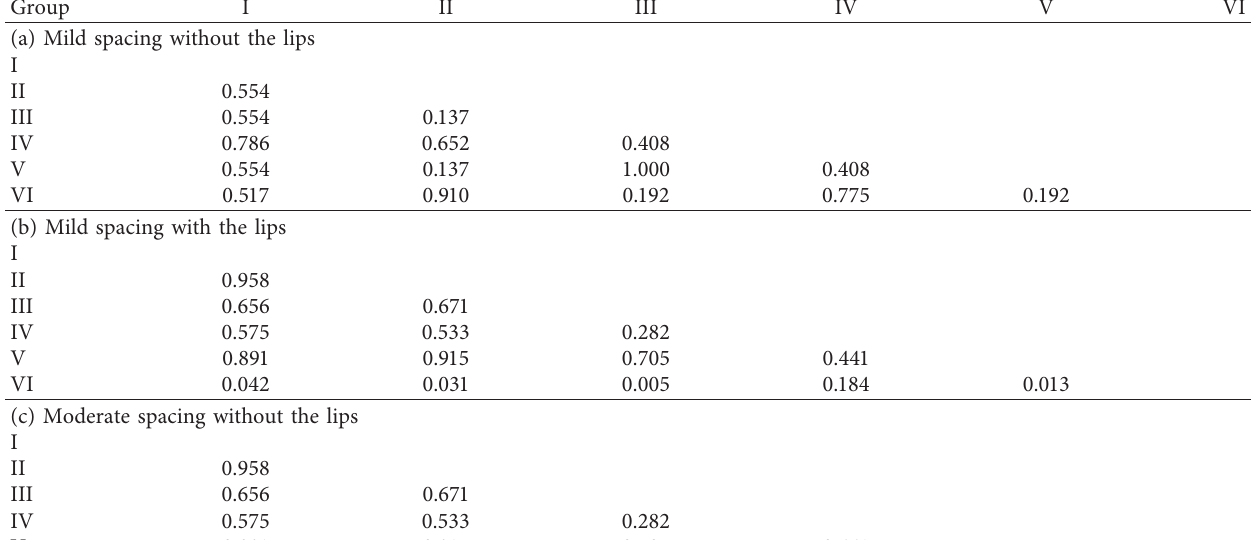
Table 4: Differences among groups in the perception of attractiveness of anterior spacing with and without the lips. Group I